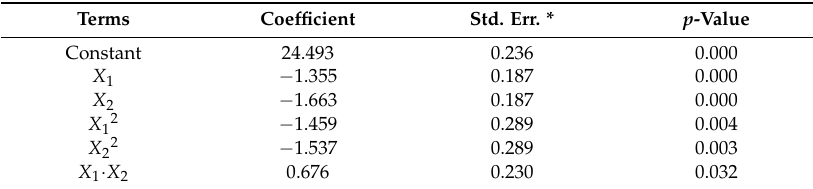
Table 2. Statistical analysis from the central composite face-centered (CCF) design experiments for CaCO 3